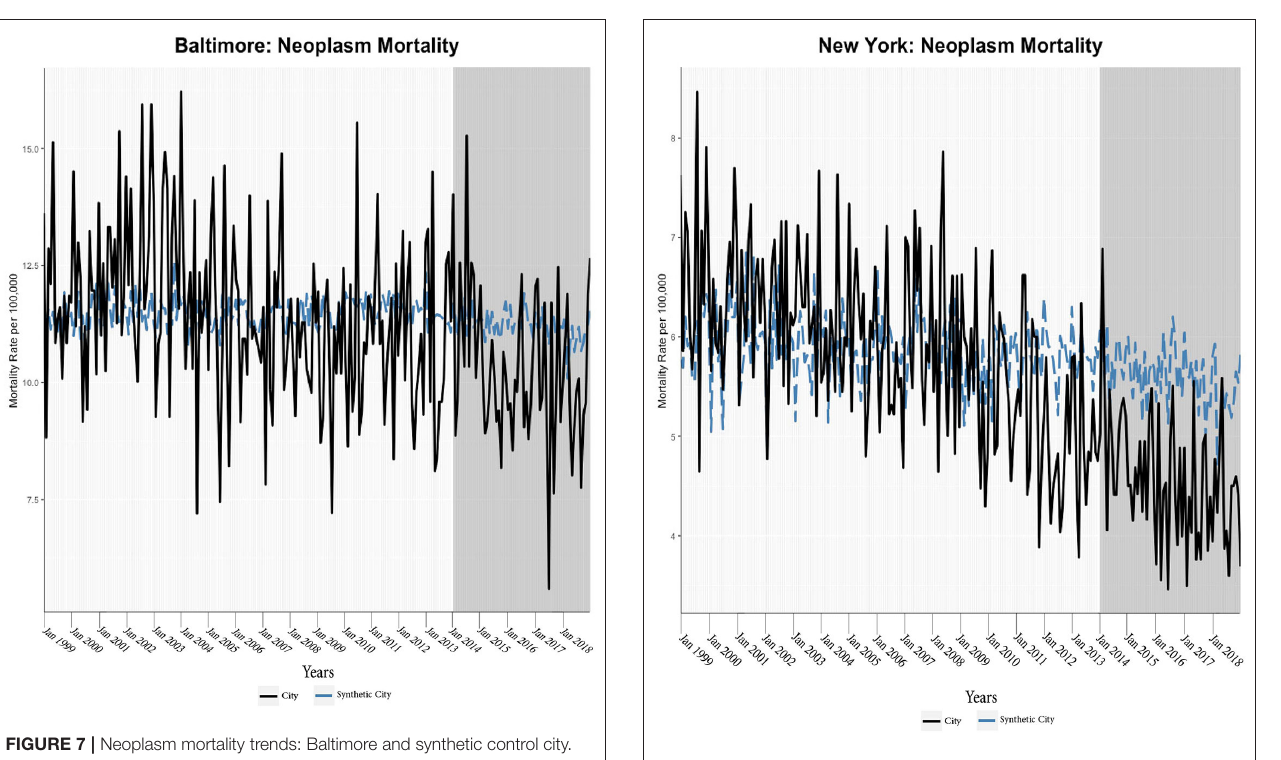
FIGURE 9 | Neoplasm mortality trends: New York and synthetic control city.